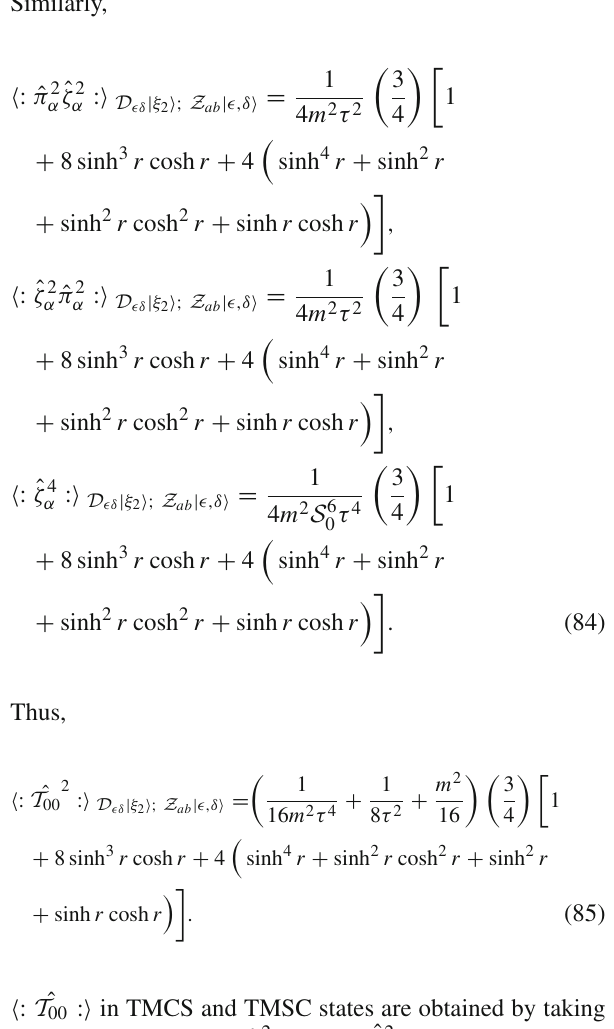
is plotted for the same range of r and 2 (cid:3) o ≈ 2 (cid:3) o